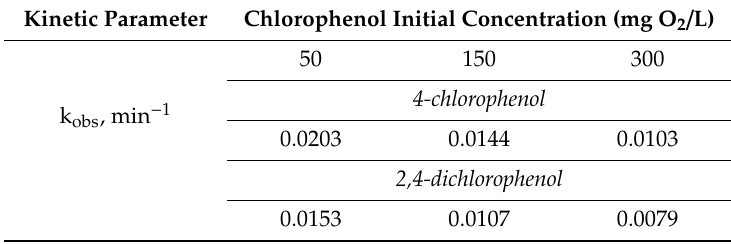
Table 1. Kinetic parameters of photocatalytic